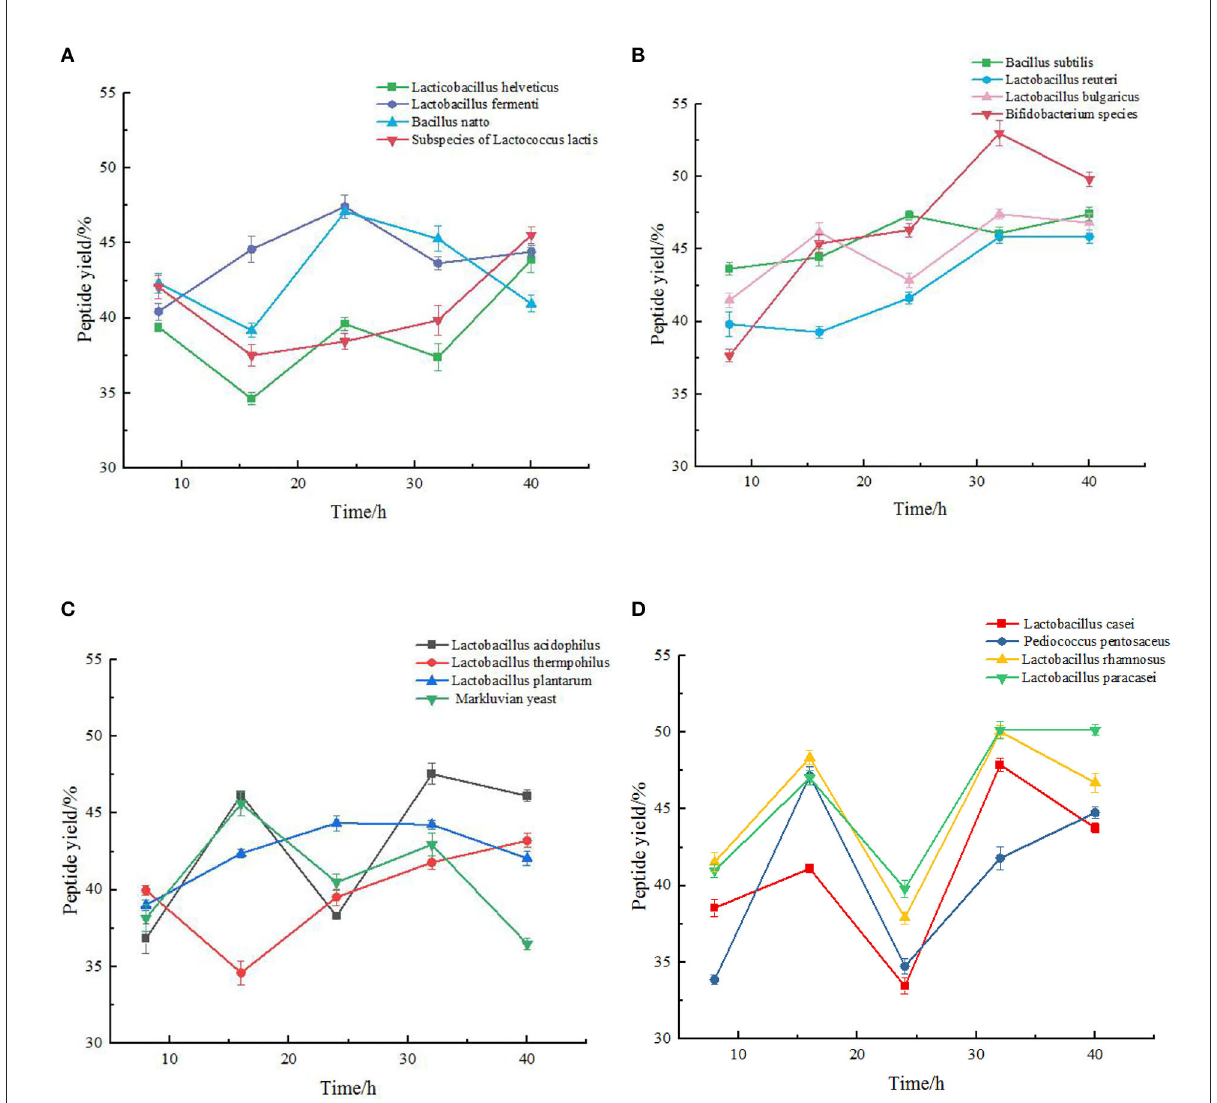
FIGURE1 Change of peptide yield (%) during the fermentation of chickpea by different species. The values are presented as the mean of three replicates ± standard deviation (SD). (A) Variation of peptide yield of chickpea fermented by Lactobacillus helveticus , Lactobacillus fermenti, Bacillus natto , Subspecies of Lactococcus lactis respectively. (B) Variation of peptide yield of chickpea fermented by Bacillus subtilis, Lactobacillus reuteri , Lactobacillus bulgaricus, Bifidobacterium species respectively. (C) Variation of peptide yield of chickpea fermented by Lactobacillus acidophilus, Lactobacillus thermophilus, Lactobacillus plantarum , and Maxruvius yeast respectively. (D) Variation of peptide yield of chickpea fermented by Lactobacillus casei, Pediococcus pentosaceus, Lactobacillus rhamnosus , and Lactobacillus paracasei respectively.